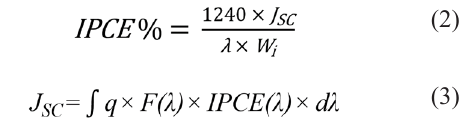
Figure 5: Comparison of spectral responses (IPCE) of DSSCs made with two different photoanodes, bare SnO incorporated SnO